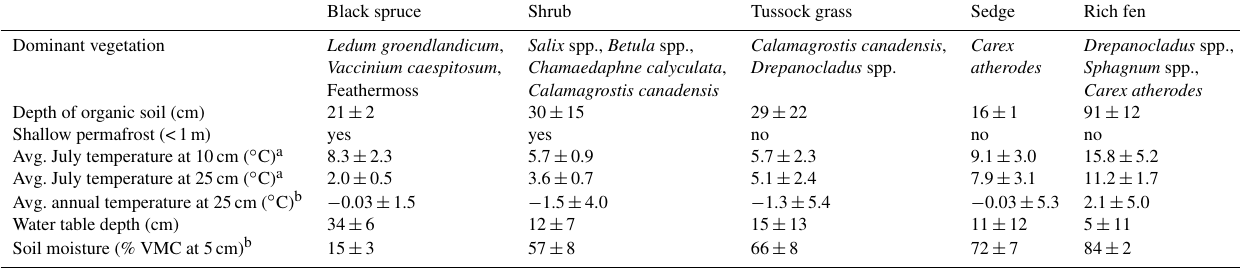
Table 1. Site biological, physical, and chemical information. Depth of organic soil, based on three soil cores, are averages with standard deviations. July temperatures are averaged for 2005–2011. Water table depth from measurements after July 15 for the years 2005–2008. Black spruce Shrub Tussock grass Sedge Rich fen Dominant vegetation Ledum groendlandicum , Salix spp., Betula